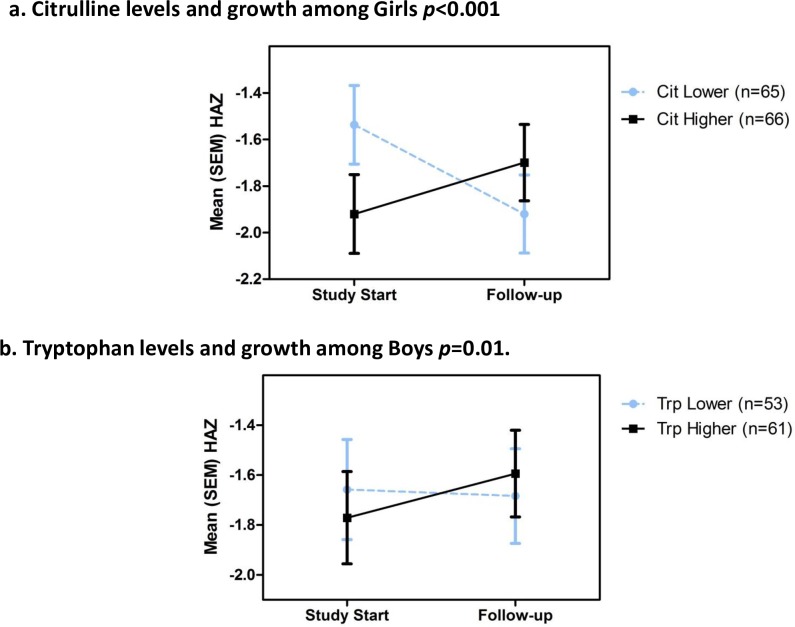
Plasma citrulline (in girls) and tryptophan (in boys) predicts subsequent better growth.A. citrulline (for which gender differs significantly) in girls (p<0.001; n = 131; median citrulline = 23.97 umol/L) and B. tryptophan in boys (p = 0.010; n = 114; median tryptophan = 66umol/L) predicts subsequent better growth.